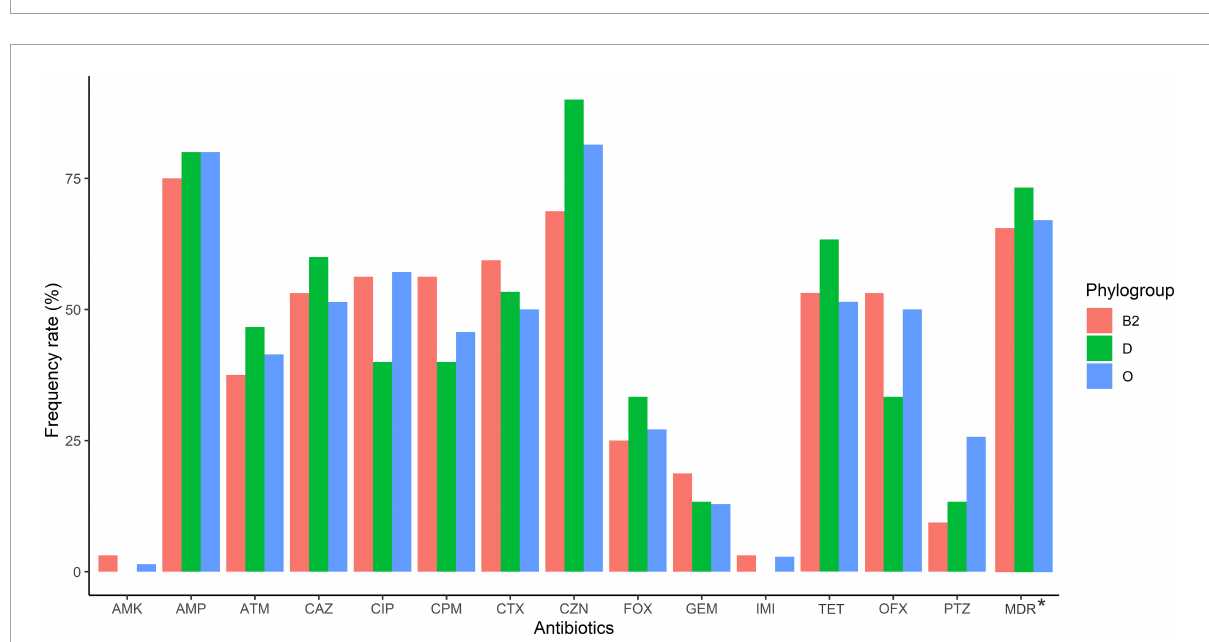
FIGURE4 Antimicrobial resistance of IBD-associated E. coli isolates according to phylogroup (B2, D, and other than B2 and D [O]). Amikacin (AMK), ampicillin (AMP), cefotaxime (CTX), piperacillin/tazobactam (PTZ), cefazolin (CZN), cefoxitin (FOX), ceftazidime (CAZ), cefepime (CPM), imipenem (IMI), aztreonam (ATM), ciprofloxacin (CIP), ofloxacin (OFX), gentamicin (GEM) and tetracycline